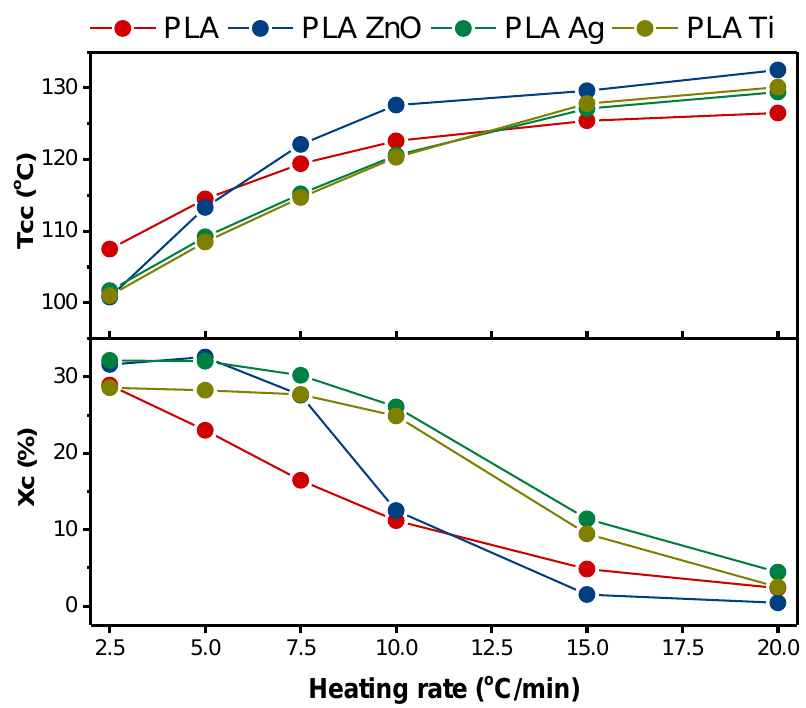
Figure 1. Effect of the heating rate and fillers on the final % crystallinity and the peak temperature of cold crystallization.